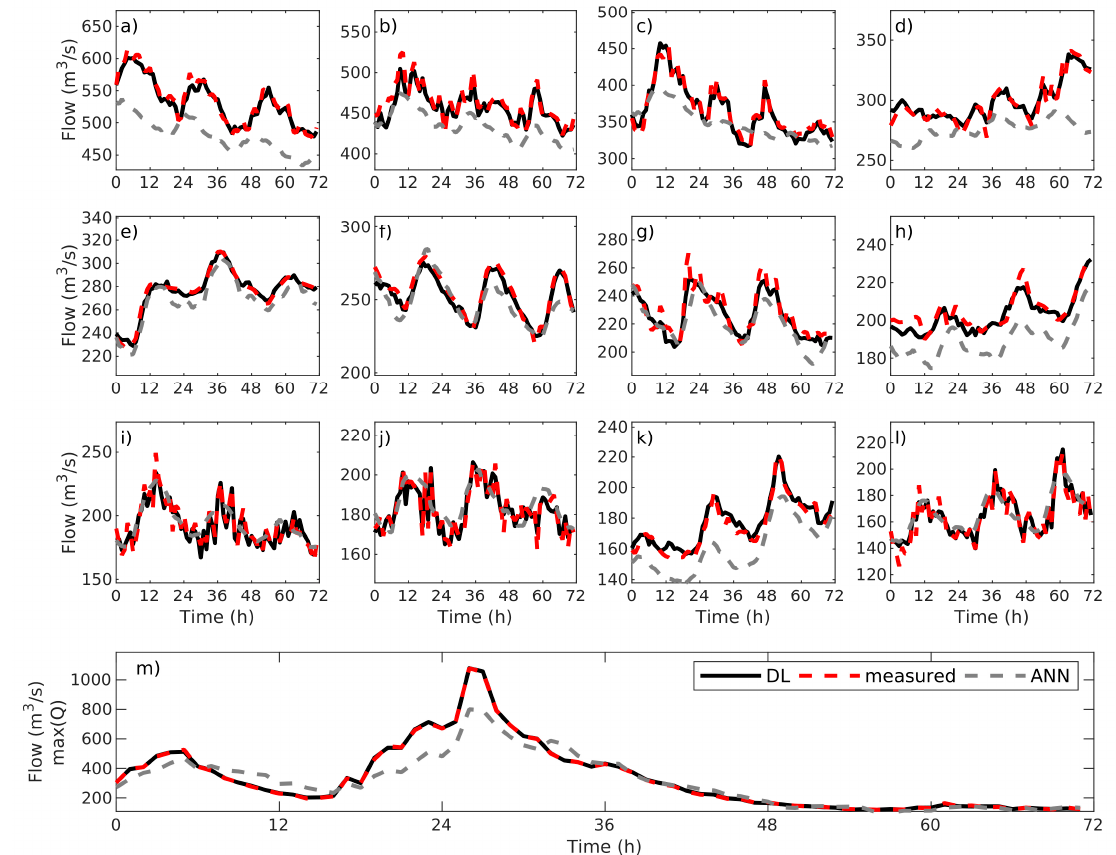
Figure 11. Comparison between predicted and observed flow for di ff erent cases identified with red open circles in Figure 11, associated to percentiles of 99.9%, 99.6%, 99%, 98%, 97%, 96%, 95%, 94%, 93%, 92%, 91% and 90%, for panels ( a – l ), respectively. ( m ) Plots predicted and observed time-series for the event with maximum flow.